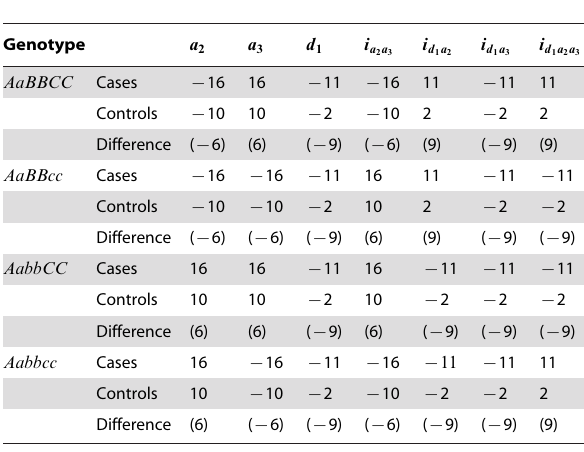
Table 10. The genetic effect components of four particular genotypes, AaBBCC , AaBBcc , AabbCC , and Aabbcc at three SNPs, Arg30Ln, Glu514Gln, and Pro979Leu, which contain the dominant | additive | additive three-locus epistasis.